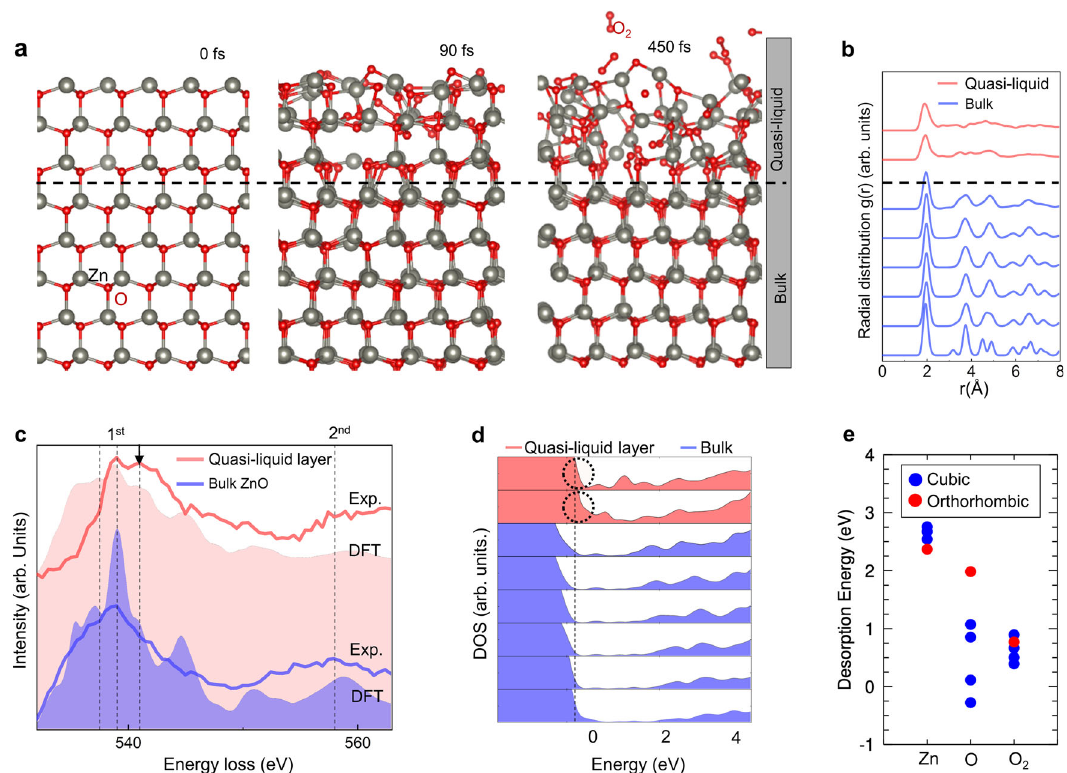
Fig.6|Characteristicsandroleofquasi-liquidlayerindissociativeevaporation ofZnO(0001).a AbinitioMDsimulationsnapshotsshowingthedisorderingofZn- de fi cientZn 1- x O(topthreebilayersabovethedashline).V Zn wereintroducedtothe top three Zn layers to make the composition the same as that of the quasi-liquid layer. Oxygen molecules (O 2 ) desorbed from the surface are indicated. Detailed results of MD simulation are given in Supplementary Figs. 17, 18, Supplementary Movie 9. b RDF of each Zn and O bilayer of the simulated structure in a . The disorderedquasi-liquidlayersurface(red)showsacharacteristicshortrangeorder of liquid state. The dash line differentiates the quasi-liquid (V Zn ) from the bulk region. c , Experimental (Exp.) EEL spectra of O-K edge (blue and red line)